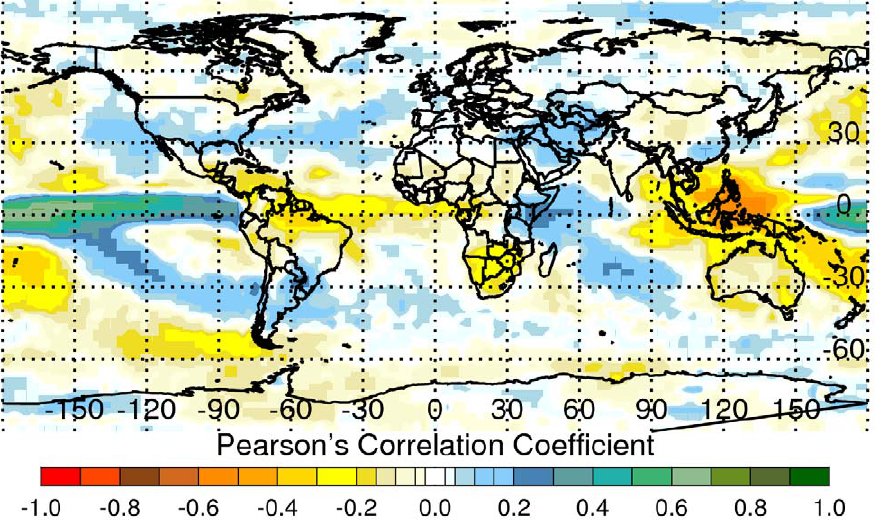
Figure 1. Summary correlation map between monthly NINO3.4 SST and rainfall anomalies, 1979–2008. Correlation of sea surface temperatures and rainfall anomalies illustrate ENSO teleconnection patterns. There is a tendency for above (below) normal rainfall during El Nin˜o ( La Nin˜a ) events over East Africa (Southern Africa, Southeast Asia). Similar differential anomaly patterns were observed for other regions, especially within the global tropics. These extremes (above or below) in rainfall influence regional ecology and consequently dynamics of mosquito disease vector populations and patterns of mosquito-borne disease outbreaks.